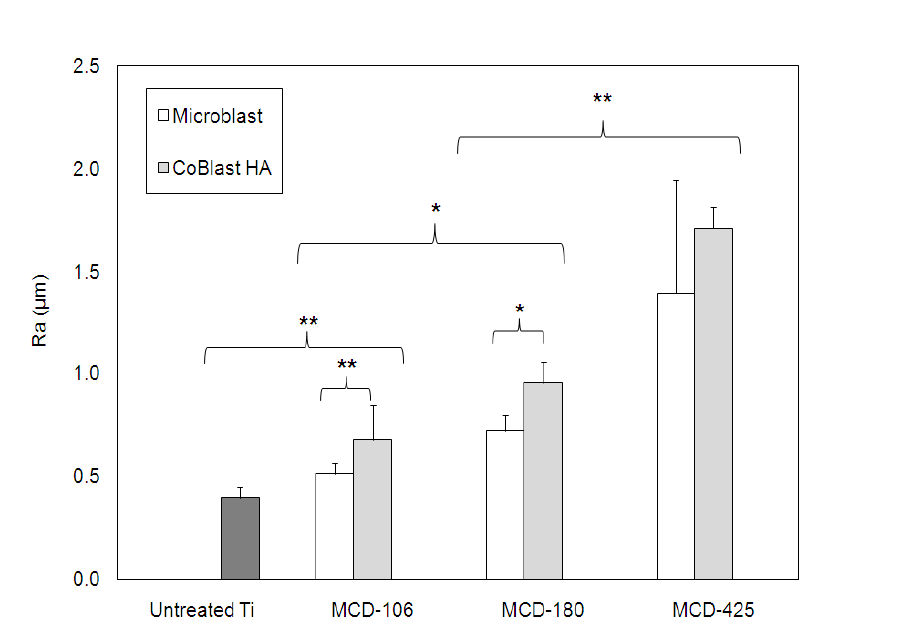
Figure 4. Surface roughness (R ) of the various modifications (* denotes p < 0.05 and ** a ascribes p < 0.01 determined using student’s